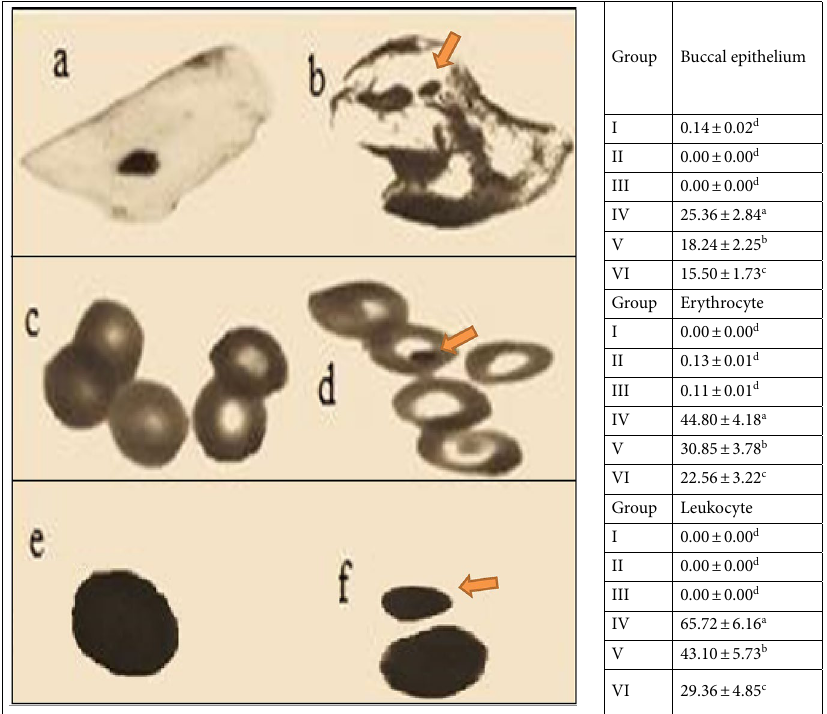
Table 3. Effects of AFM 2 and quercetin on MN frequencies in different cells of albino mice. Group I: control, Group II: 25 mg/kg b.w quercetin, Group III: 50 mg/kg b.w quercetin, Group IV: 16 mg/kg b.w AFM 2 , of erythrocyte cell (c), erythrocyte cell with MN (d), normal appearance of leukocyte cell-lymphocyte (e), leukocyte with MN cell-lymphocyte (f). Means shown with different letters (a–d) on the same line are statistically significant ( p <